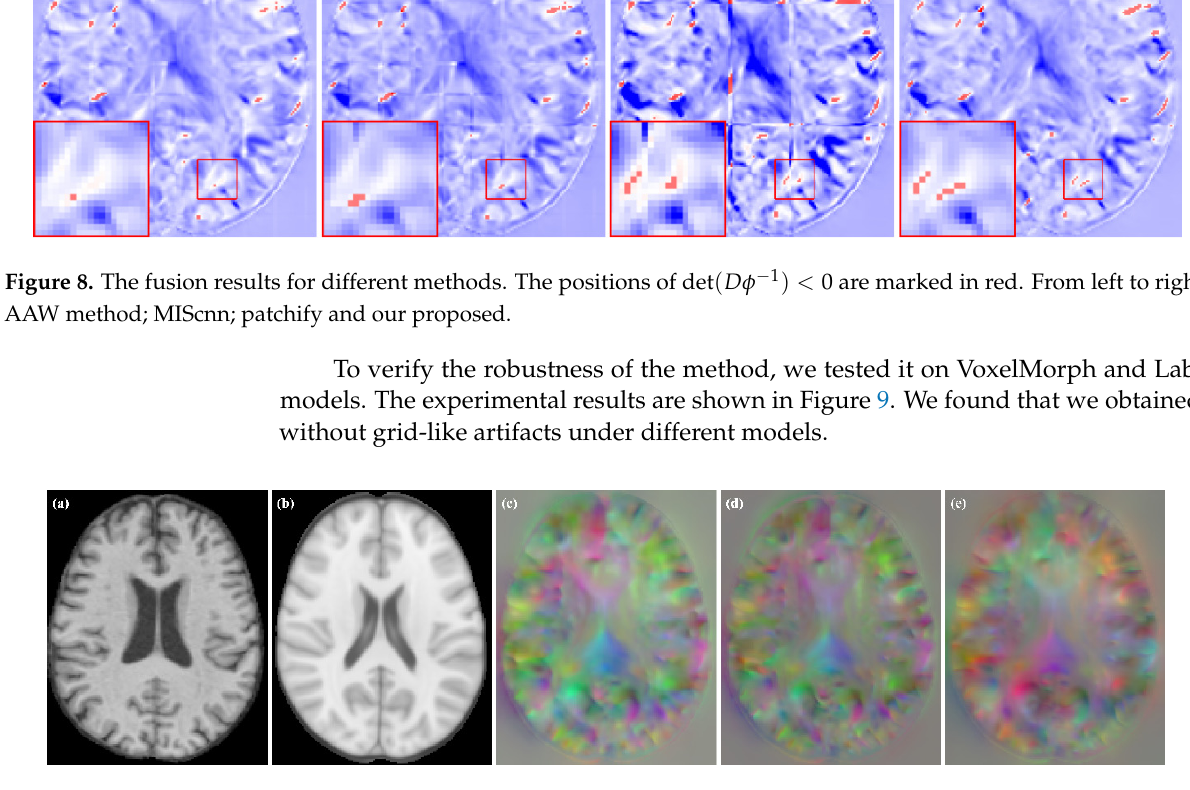
Figure 9. moving image, fixed image and DDFs obtained for different models. ( a ) moving image; ( b ) fixed image; ( c ) VoxelMorph; ( d ) VoxelMorph (JD); ( e ) Label-reg.